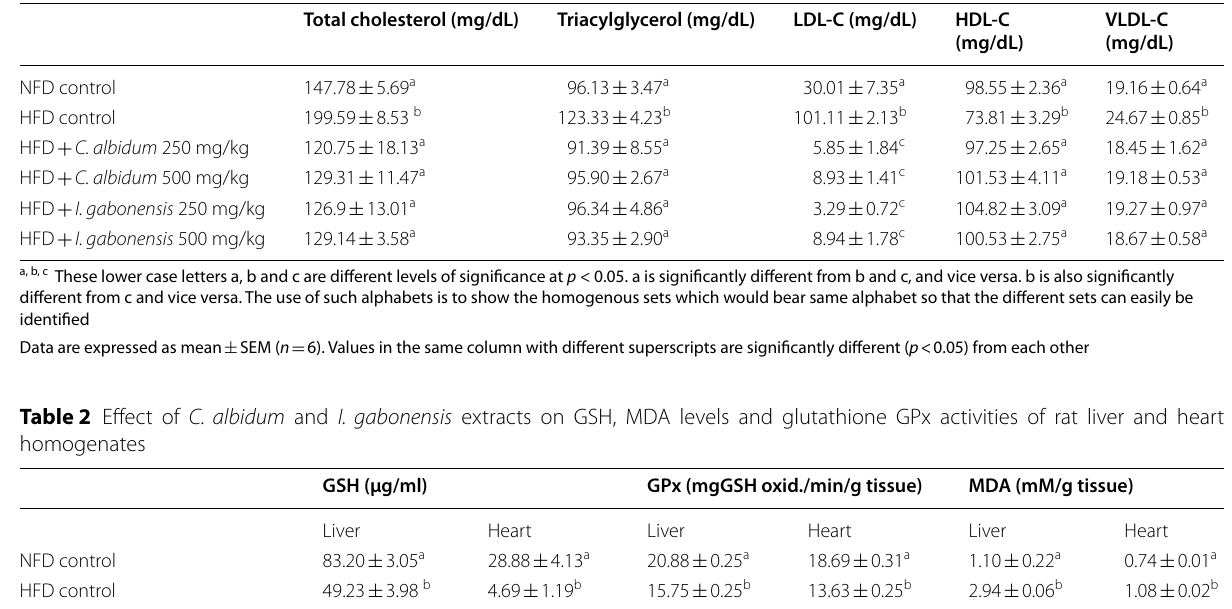
Table 1 Effect of C. albidum and I. gabonensis extracts on lipid profile of rats fed with HFD